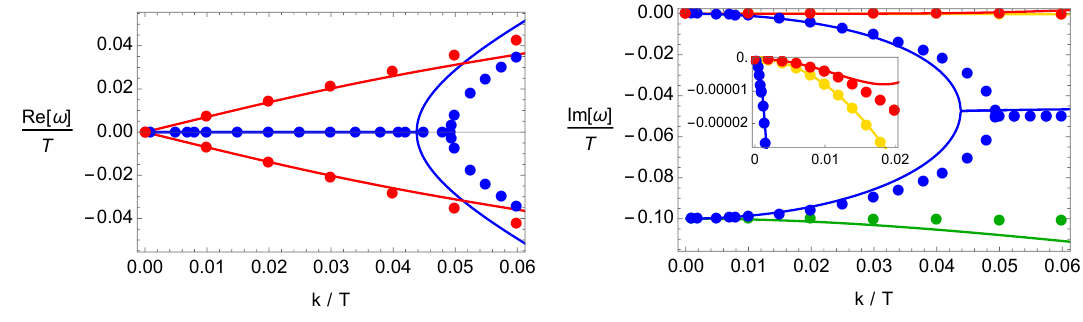
Figure 1 . Dispersion relations of the lowest QNMs at zero density ( µ/T = 0 ) and B/T 2 = 0